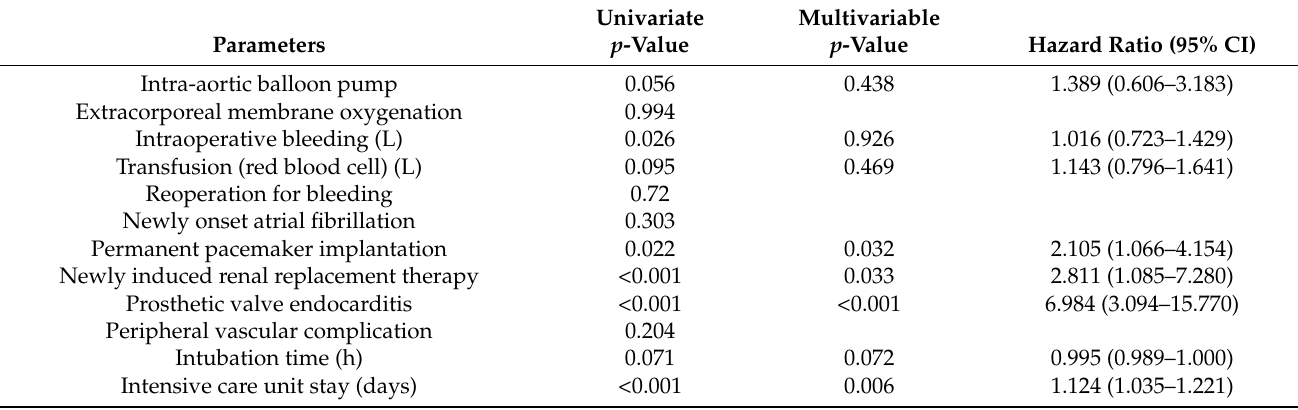
Table 5. Postoperative risk factors for the primary endpoint (Cox hazard